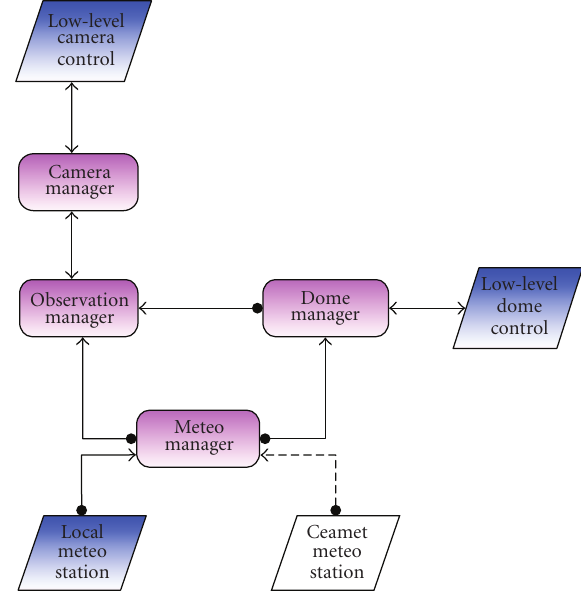
Figure 1: Flux diagram of the main cycle of the observation